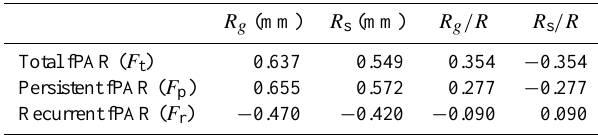
Table 1. Correlation coefficients between vegetation cover and wa- ter balance components over the 193 study catchments.